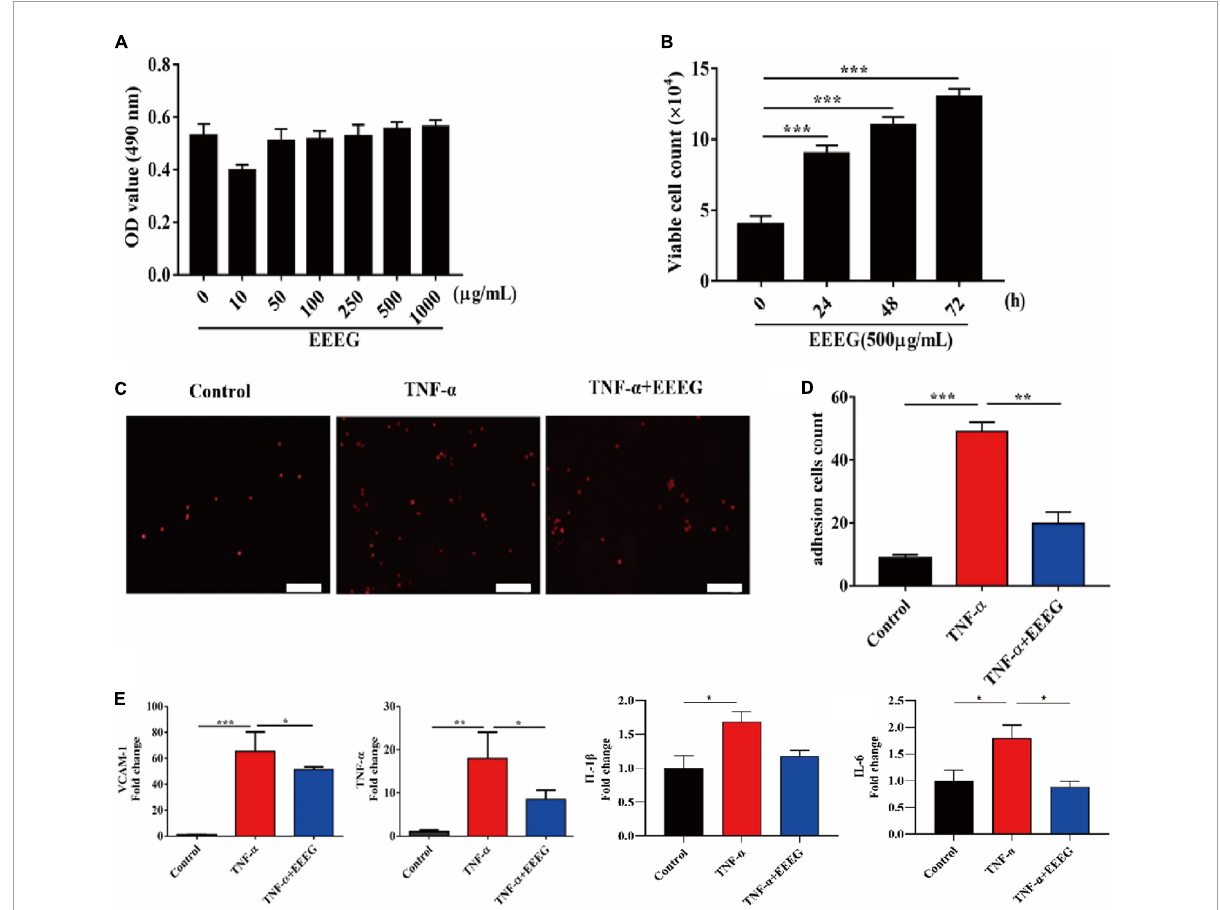
FIGURE4 EG extract (EEEG) suppresses pro-inflammatory activation of HUVECs. (A) HUVECs were treated with different doses of EEEG (0, 10, 50, 100, 250, 500, and 1,000 µ g/ml) for 24 h, and cell viability was determined by MTT assay ( n = 5). (B) HUVECs were incubated with EEEG (500 µ g/mL) for 0, 24, 48, and 72 h, and then cell proliferation was examined by direct cell counting ( n = 3). (C,D) Representative images of adhesion of fluorescence-labeled THP-1 cells to HUVECs pretreated with or without EEEG (500 µ g/mL) for 24 h followed by stimulation with or without TNF- α (10 ng/ml) for 4 h (C) (scale bar, 50 µ m), and quantification of the adherent THP-1 cells ( n = 3) (D) . (E) Gene expression levels of Vcam-1 , Tnf- α , Il-1 β , and Il-6 in HUVECs pretreated with or without EEEG (500 µ g/mL) for 24 h followed by stimulation with or without TNF- α (10 ng/ml) for 4 h ( n = 3). Data are mean ± SEM. * P < 0.05, ** P < 0.01, *** P <